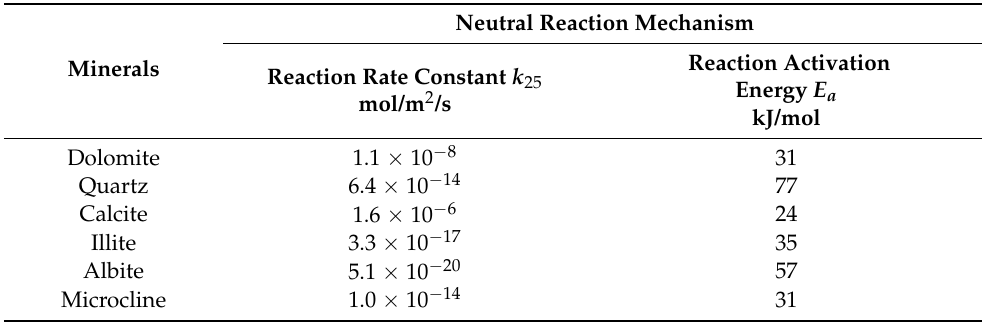
Table 5. Kinetic parameters of the neutral reaction mechanism of the main minerals.